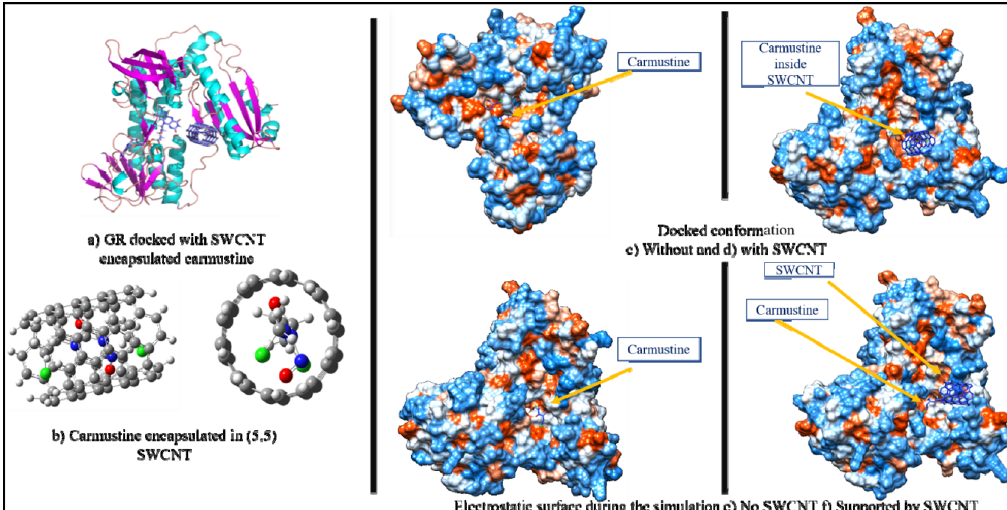
Figure 4. ( a ) SWCNT-carmustine docked in GR conformation ( b ) (5,5) SWCNT carrying the drug and Electrostatic surface corresponding to docking results ( c , d ) and during the simulation ( e , f ) in absence and presence of SWCNT support